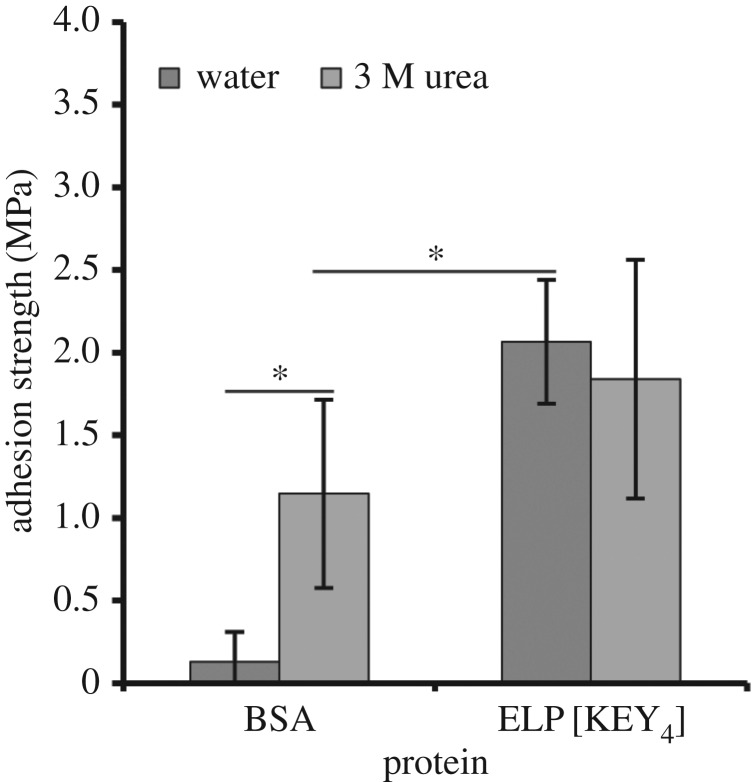
Effect of a denaturant (3 M urea) on bulk adhesion strength. The adhesion of the highly structured BSA protein was compared with the relatively unstructured ELP[KEY4-48] protein. The addition of the denaturant had a highly positive effect on BSA adhesion, whereas no effect was observed with ELP. Statistically significant differences (unpaired t-test, p < 0.05) are indicated by an asterisk.